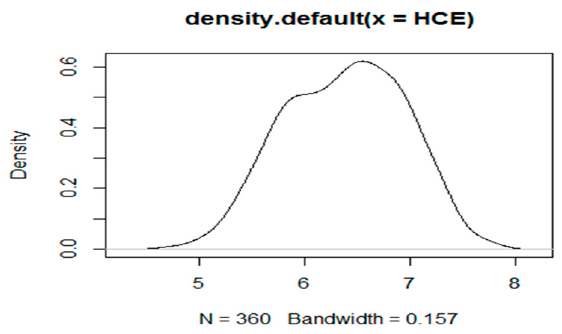
Figure 2. Density function diagram of HCE(Health care expenditure).